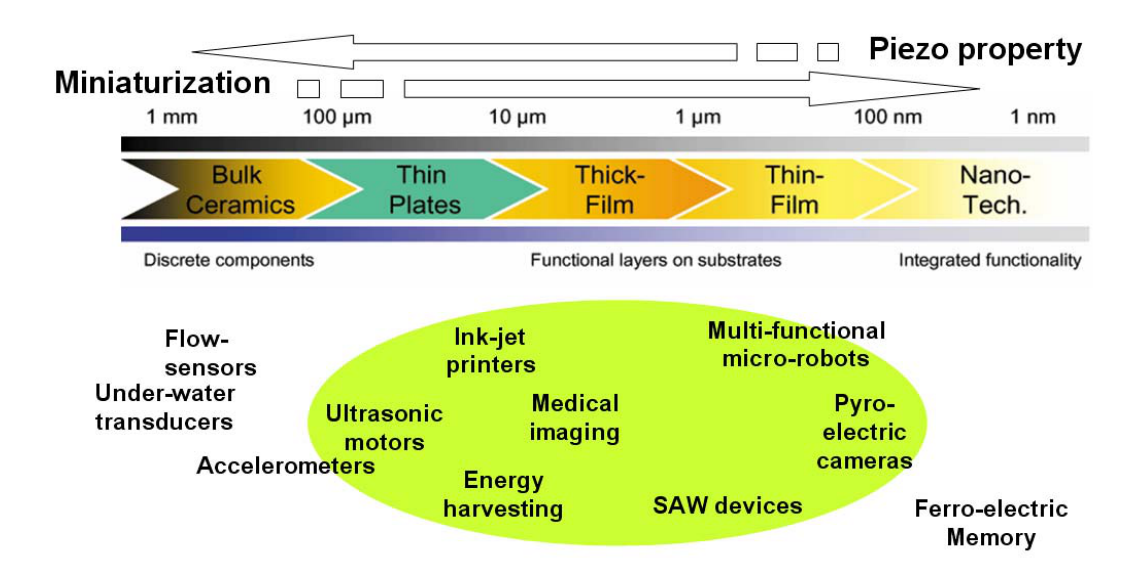
Figure 5. Application areas of piezoelectric materials with varying